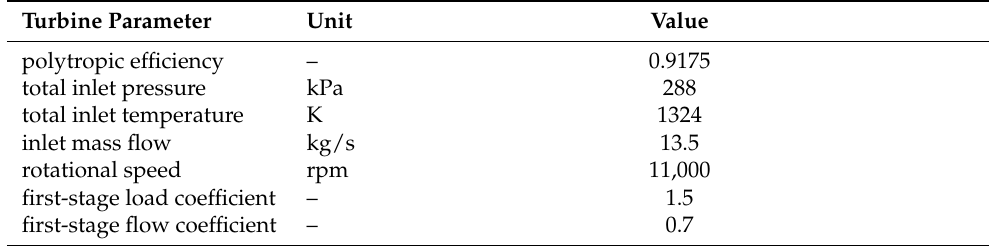
Table 2. Reference low-pressure turbine